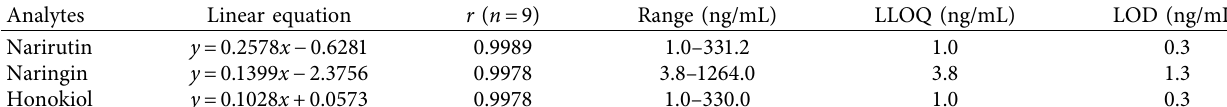
Table 2: The linear equation, range, and LLOQ of narirutin, naringin, and honokiol. Analytes